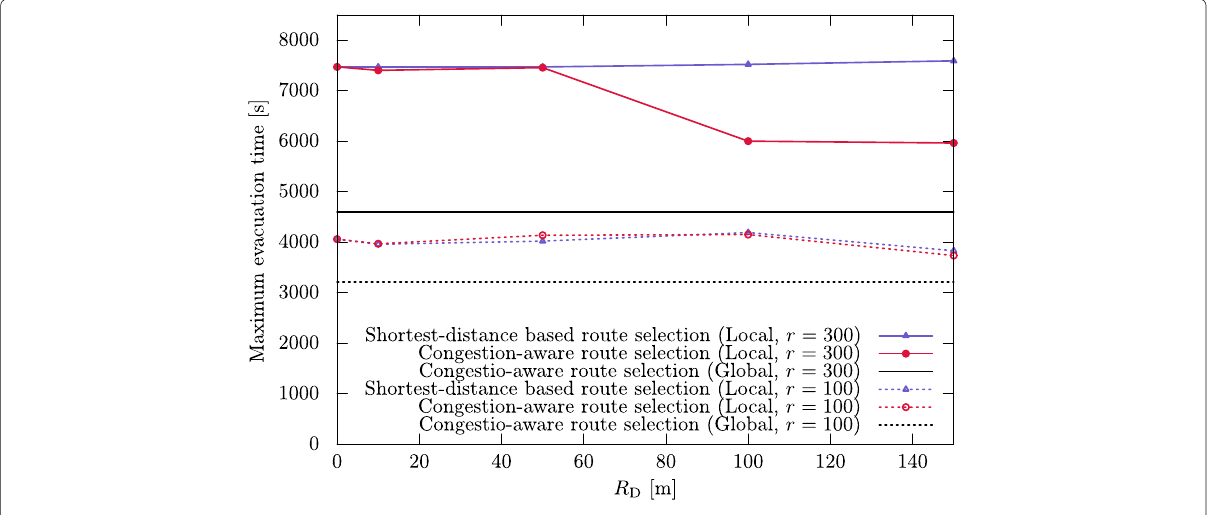
Fig. 10 Transmission range vs. maximum evacuation